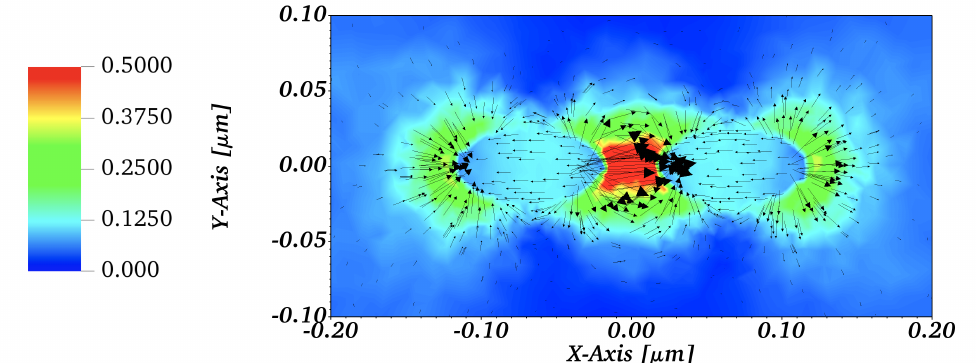
Figure 15. Real part of the electric field eigenvector at 20 nm above the substrate at a wavelength of 632.2 nm (dipolar mode-4 of Table